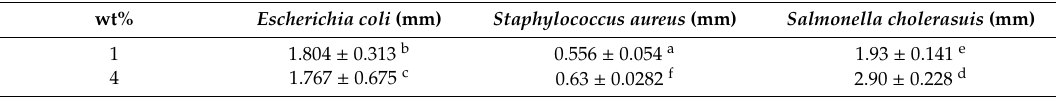
Table 2. The length and diameter of dry bacterial colonies at 1 wt% and 4